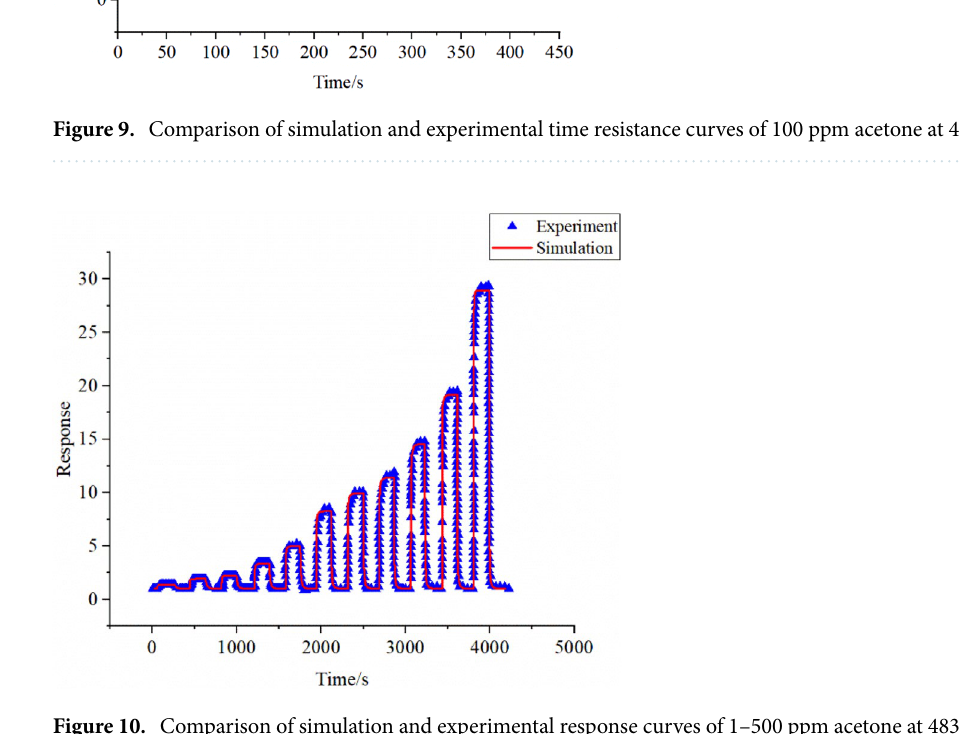
Figure 10. Comparison of simulation and experimental response curves of 1–500 ppm acetone at 483